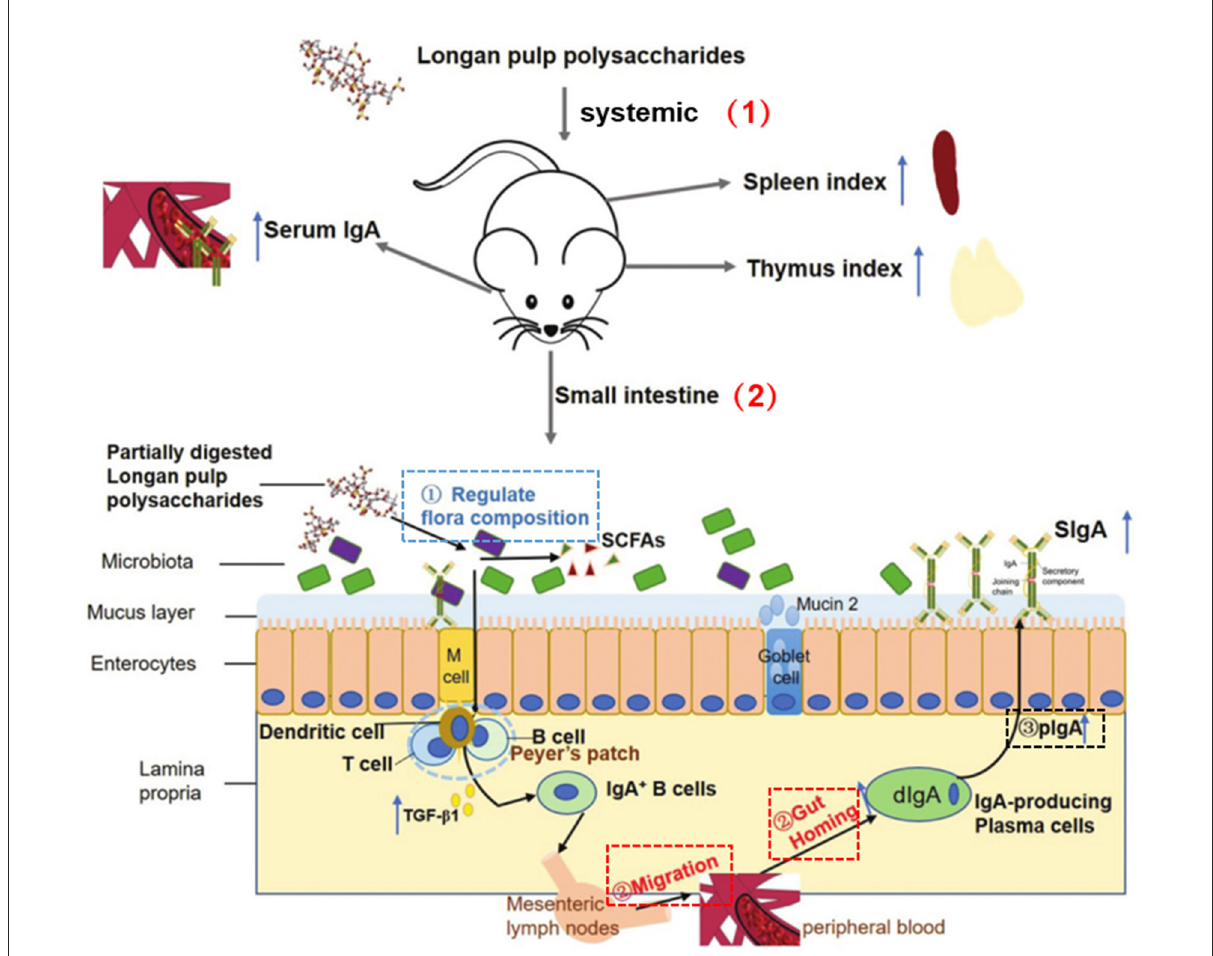
FIGURE5 LP regulated systemic and intestinal immunity (89). (1) Systemic immunity: LP increased spleen and thymus indexes and serum IgA level. (2) Intestinal immunity: ‹ LP regulated intestinal microbiota composition via utilization by partial commensal bacteria; › LP promoted the migration and gut homing of IgA + plasma cells; fi LP directly stimulated transcytosis of dIgA-pIgR and